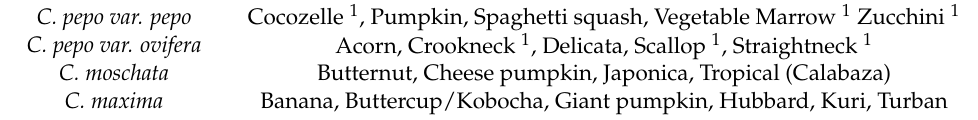
Table 4. Commonly produced fruit morphotypes of Cucurbita species (sources: 103–105). C. pepo var.